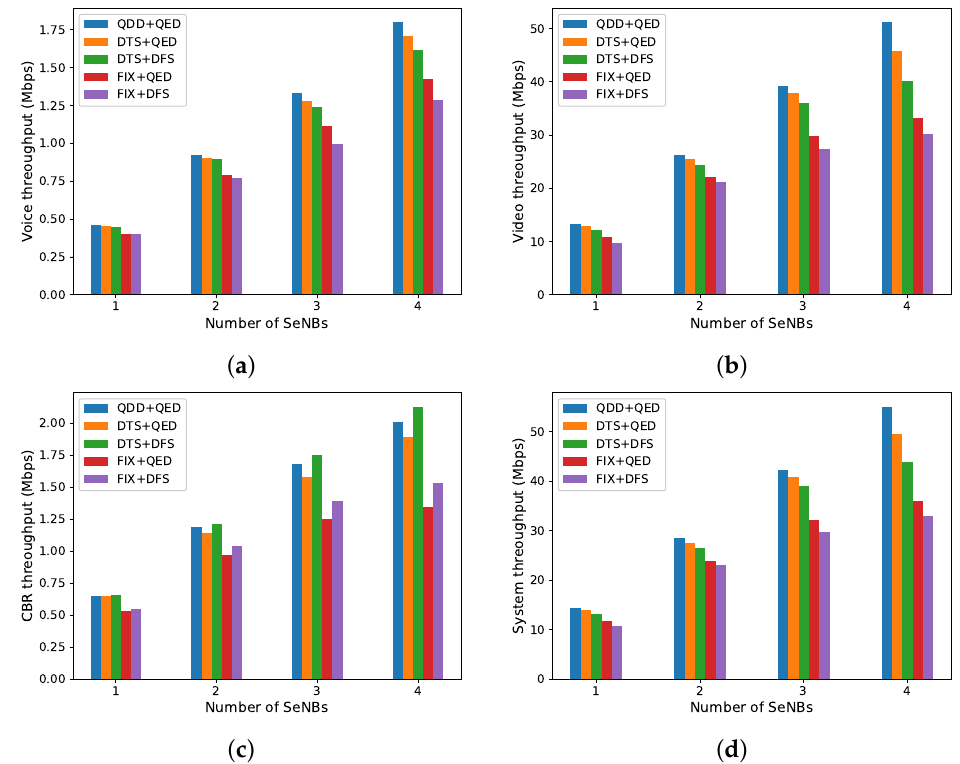
Figure 7. Simulation results on ( a ) voice, ( b ) video, ( c ) CBR, and ( d ) system throughput when varying the number of